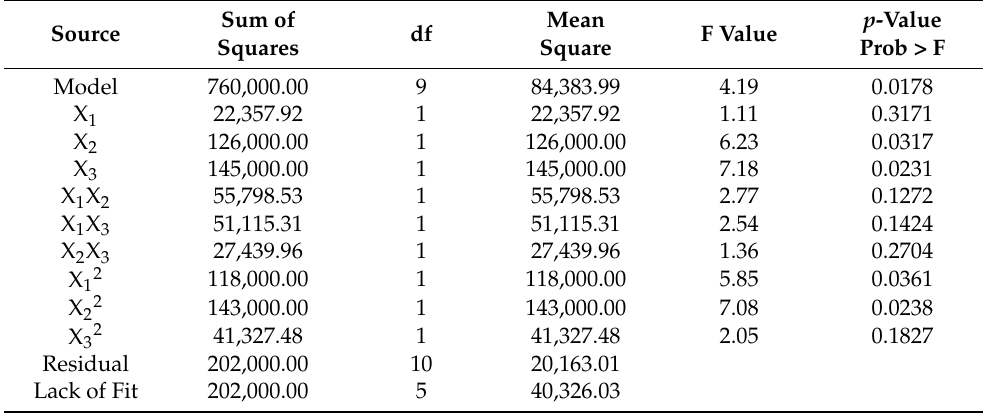
Table 2. ANOVA of the fitting model for hydrogen